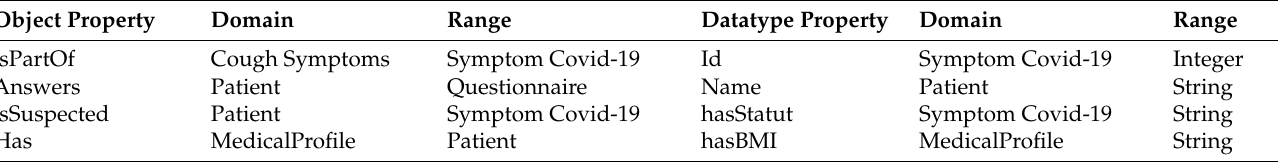
Table 6. Four properties that are Involved in the detection system.